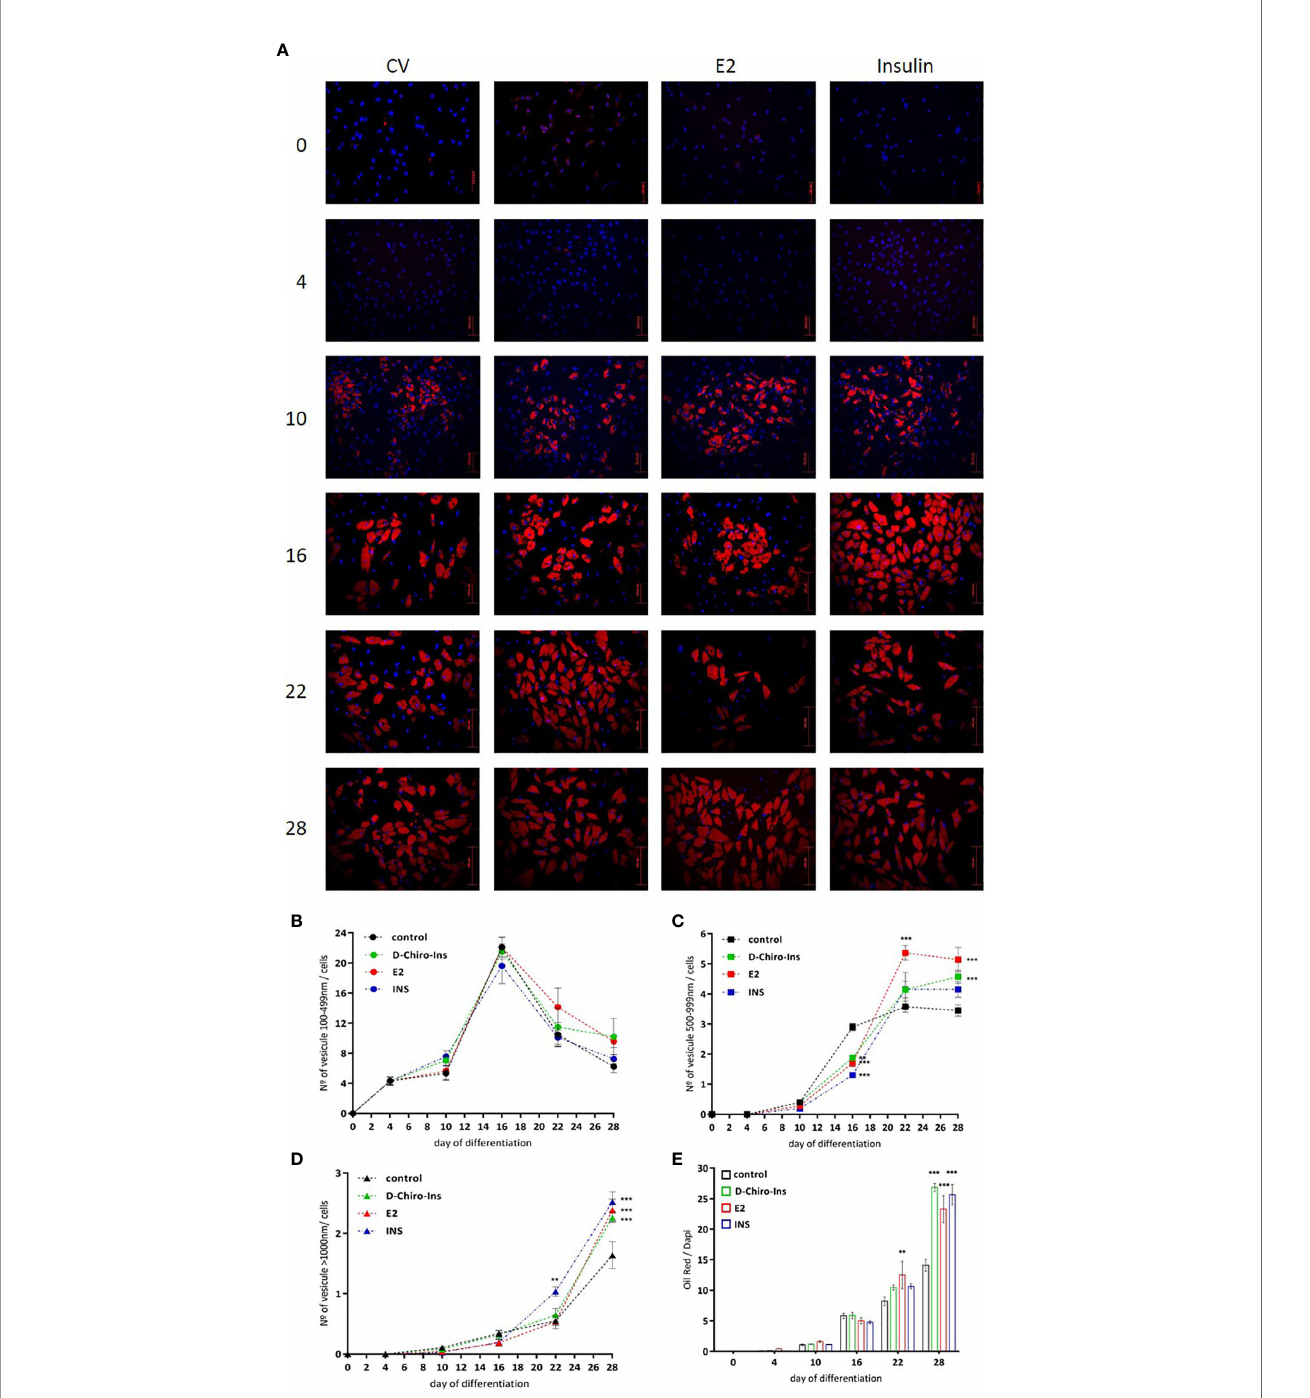
FIGURE 4 | D-Chiro-Ins modulates SGBS cells differentiation. (A) SGBS were treated with D-Chiro-Ins 10 − 8 M, E2 10 − 9 M, INS 10 − 7 M or without treatment (cv, control) during differentiation according to differentiation protocol. Lipid droplets (LD) formation rate was observed with oil red/dapi staining, on days 0, 4, 10, 16, 22 and 28 of the differentiation process. Images representative of three independent experiments taken with immuno fl uorescence microscope assessed at magni fi cation of 20×. Red: oil red; blue: dapi; bar: 200 nm. (B – D) Analysis of different size of LD produced during the differentiation: 100 – 499, 500 – 999 and >1000 nm size. (E) Analysis of lipid accumulation during differentiation, the results were expressed as ratio of the oil red intensity of lipids-droplets and dapi as a nuclear staining dye (oil red/dapi). All the results are presented as mean ± SEM after three independent experiments. Results were analyzed statistically by two-way RM ANOVA. Differences between experimental treatments and control group at the same matching time were analyzed by Dunnett ’ s multiple comparisons test (**p <0.01, ***p <0.001 versus control at the corresponding time). D-Chiro-Ins, D-chiro-Inositol; E2, 17 b -estradiol, INS,